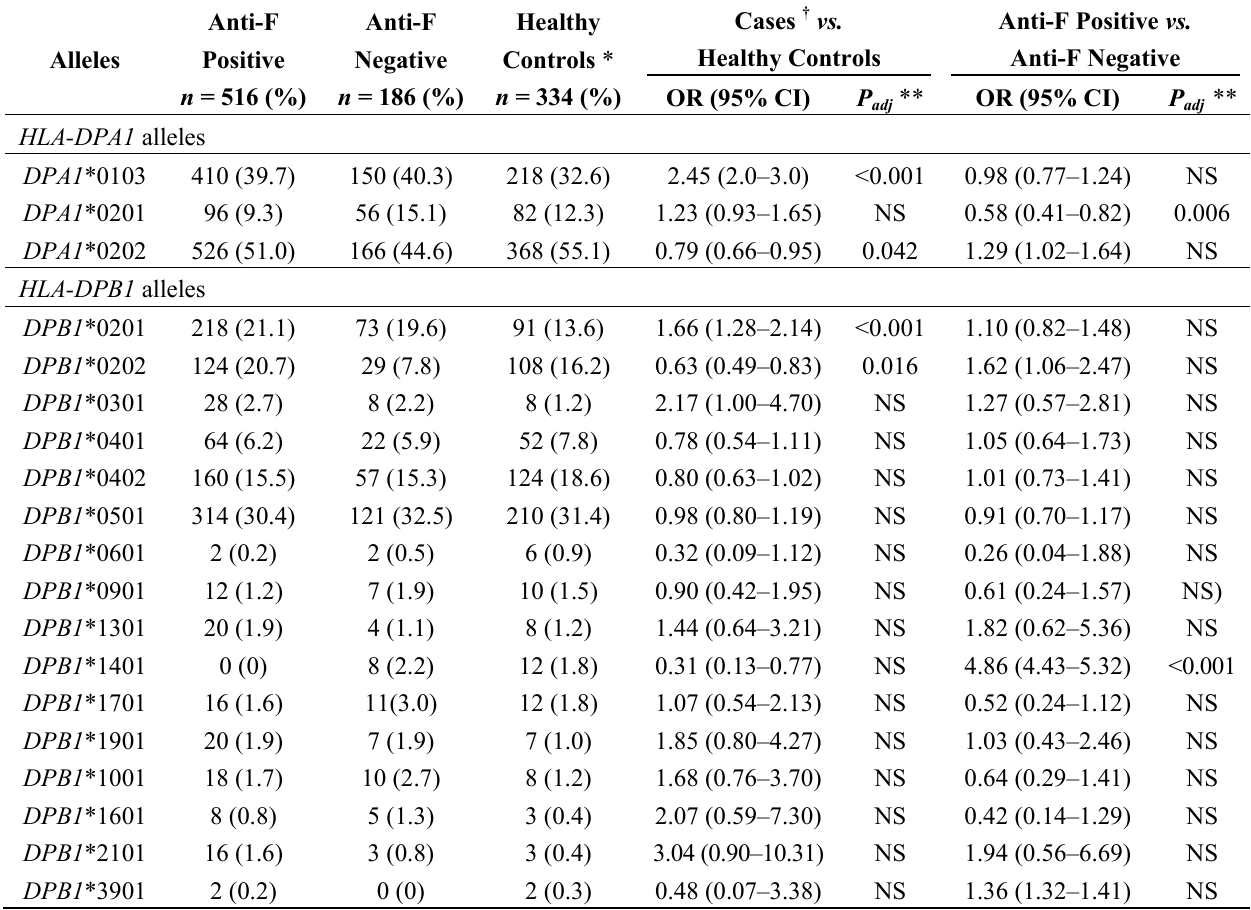
Table 5. Distribution of HLA-DP alleles among the group of anti-F negative patients, anti-F positive patients and healthy controls.